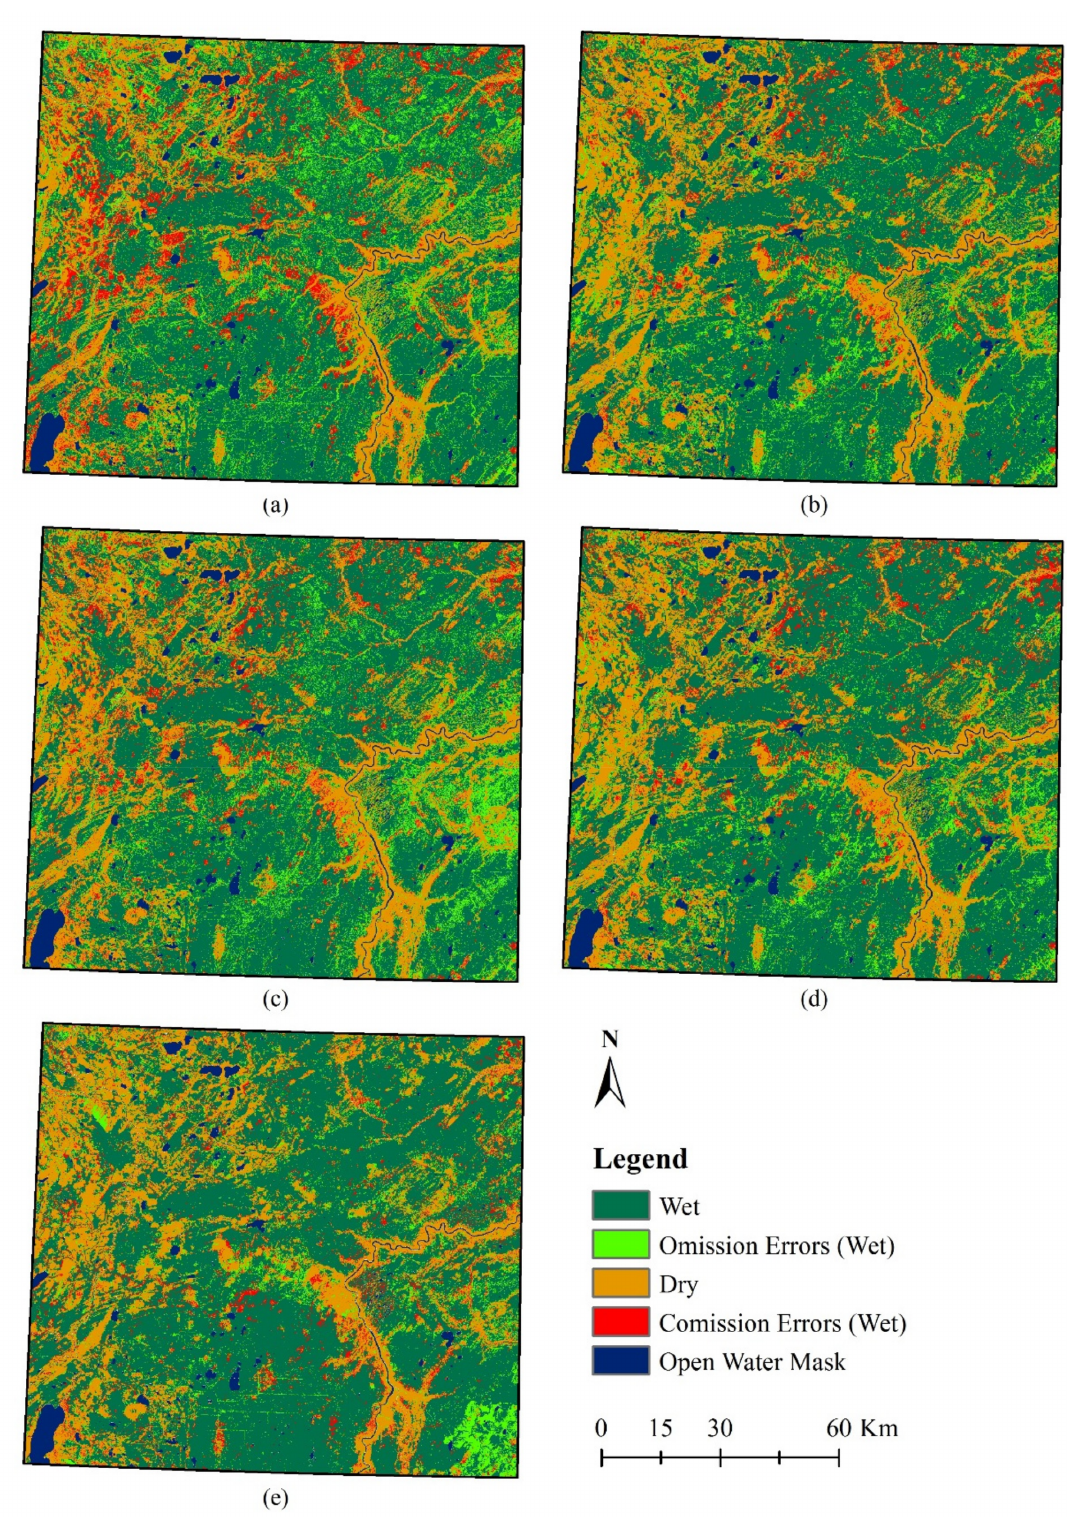
Figure 7. Classification errors of omission and commission, along with correctly-classified Wet and Dry class pixels, generated for the ( a ) T model , ( b ) TO model , ( c ) TS model , and ( d ) TOS model classifications and the ( e )